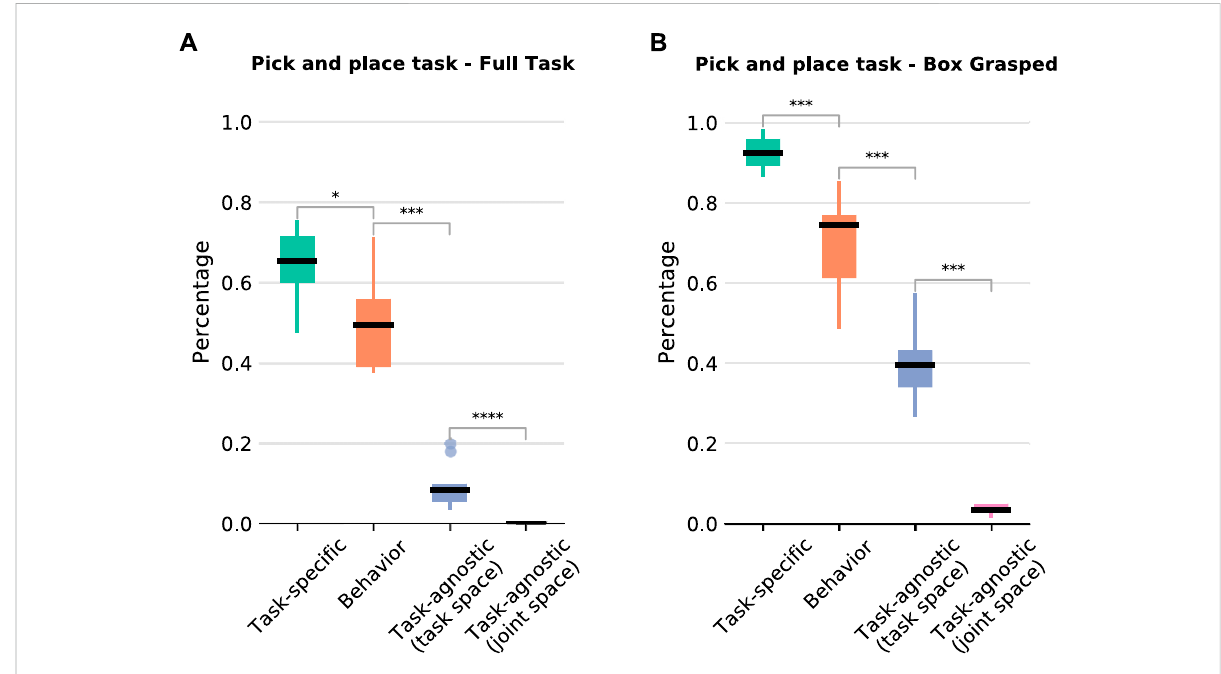
FIGURE 7 Pickandplace taskresultsover10independenttrainings.Thenumberofstarsindicatesthatthe p -valueoftheMann-WhitneyUtestislessthan 0.05, 0.01, 0.001, and 0.0001 respectively. (A) Percentage of episodes completing the full task (grasp the box and place it inside the basket) for each policy structure. (B) Percentage of episodes in which the box is successfully grasped but it was not placed inside the